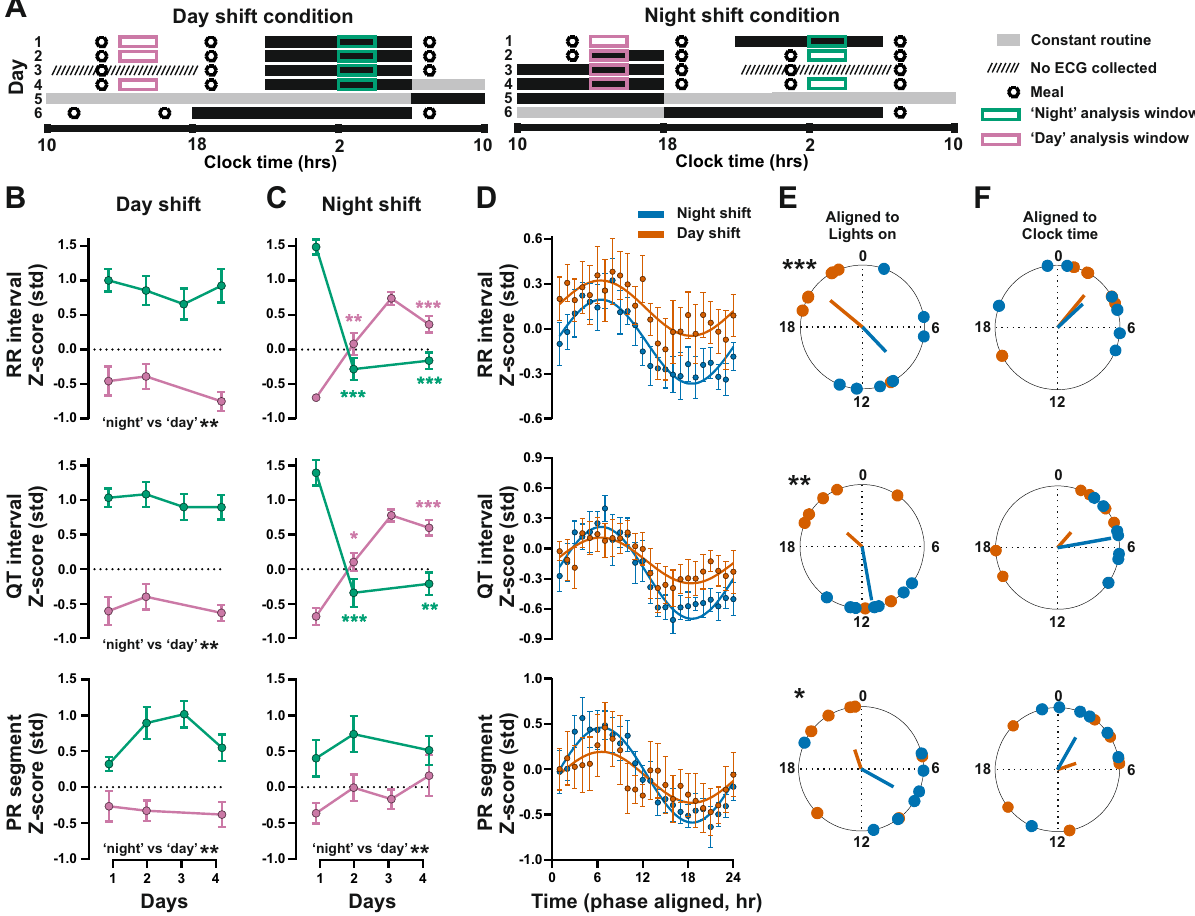
Fig. 2 ECG response under simulated night-shift and constant routine. A Schematic of 6-day laboratory session with simulated day-shift (left) and night- shift (right) routines ( n = 7 individuals/group 21 ). B , C ECG parameters recorded during mid-day (pink) and mid-night (green) showed a rapid reversal of RR and QT interval rhythms, but not that of PR seg in response to the switch to night-shift behavioral routine. Two-way ANOVA with repeated measures, colored asterisks indicate the difference from day 1. D Hourly binned z-scored group data and sinusoid fi ts from day- (orange) and night-shift (blue) conditions. Data presented as group mean ± SEM. E , F Timing (acrophase) of individual rhythm peaks relative to lights on (i.e., start of constant routine) ( E ) or external clock time ( F ). Asterisks indicate differences between groups (Watson – Williams test). * P < 0.05, ** P < 0.01, *** P < 0.001. Source data and statistical details are provided as a Source Data